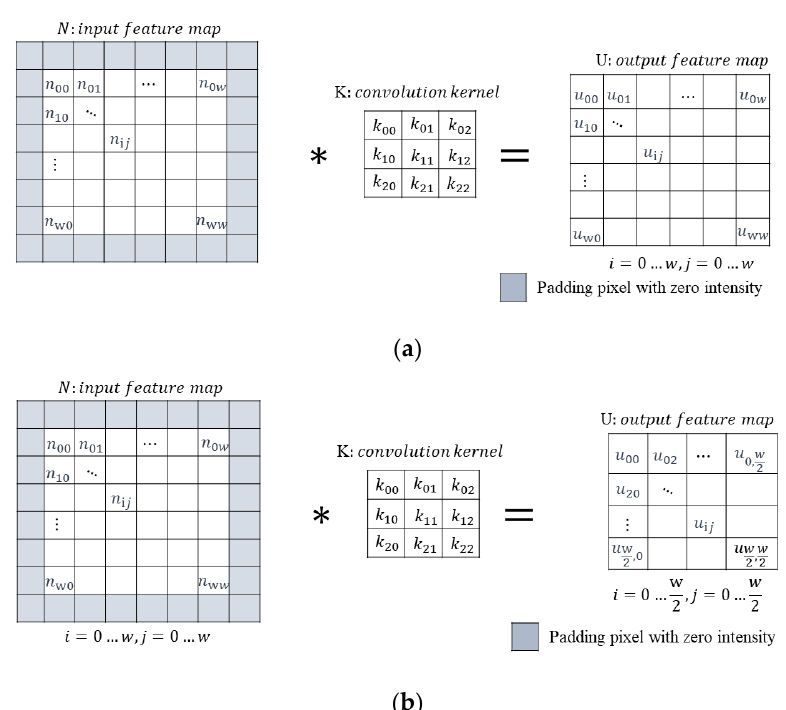
Figure 2. Mechanism of a 3 × 3 convolution operation with different strides on the input feature map N with a size of w × w pixels: ( a ) convolution with a stride of one, and ( b ) convolution with a stride of two.